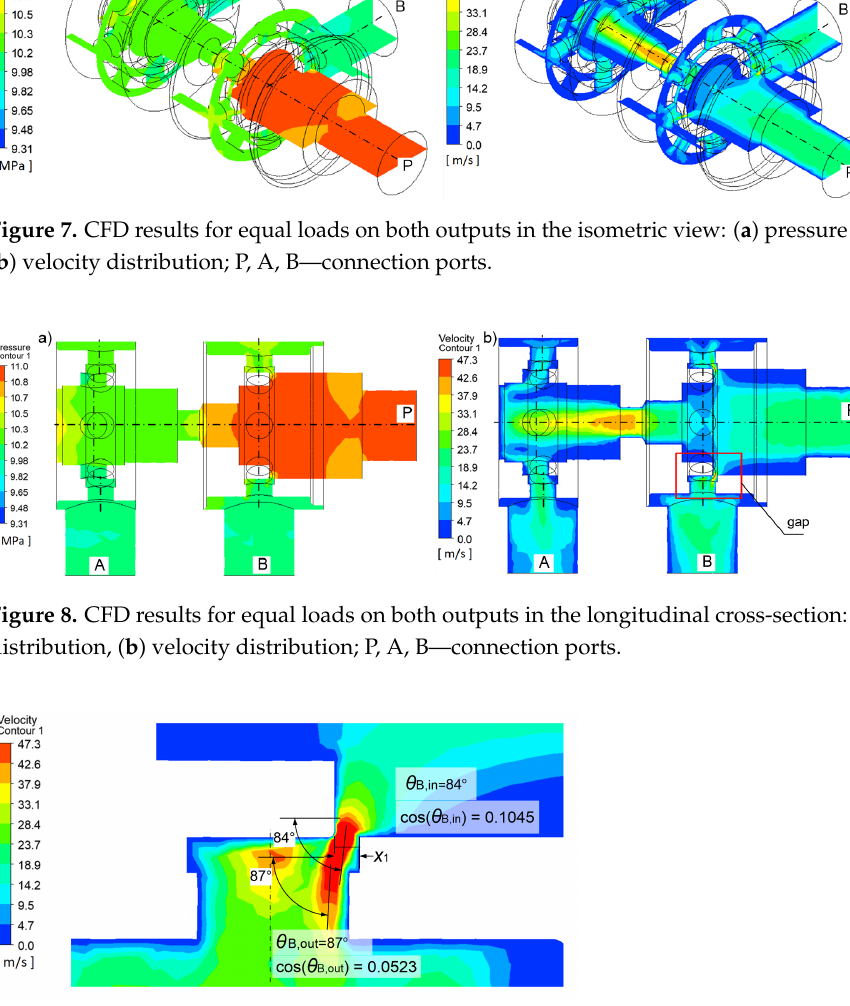
Figure 9. CFD results for equal loads on both outputs: jet angle in the B gap; θ B , in , θ B , out —jet angle at inlet and outlet; P, A, B—connection